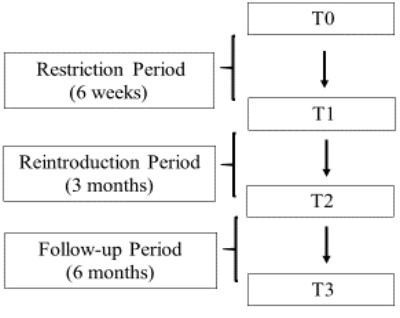
Figure 1. Flow diagram study design.